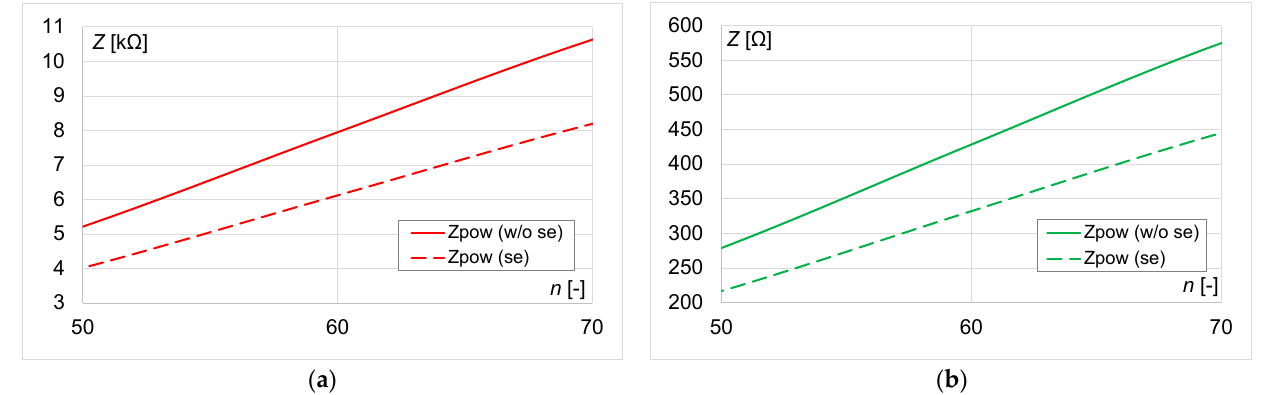
Figure 16. Load impedance for the cases with and without skin effect at 1 MHz for the large coil at